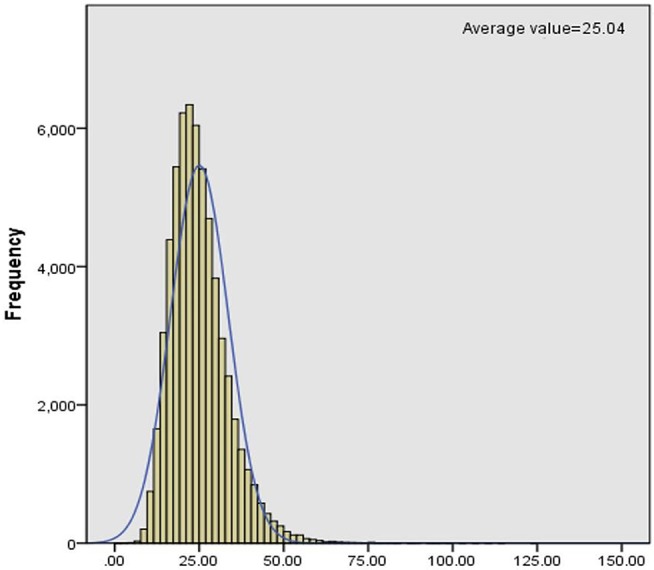
Frequency distribution histogram of C0.